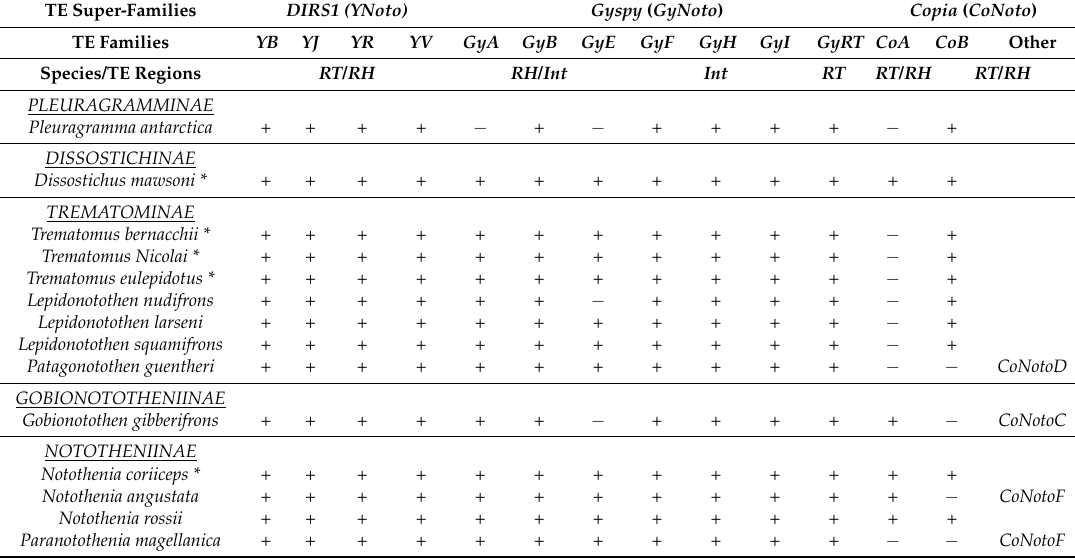
Table 1. Distributions of four families of DIRS1 ( YNoto ), seven families of Gypsy ( GyNoto ) and six families of Copia ( CoNoto ) in the nototheniid examined